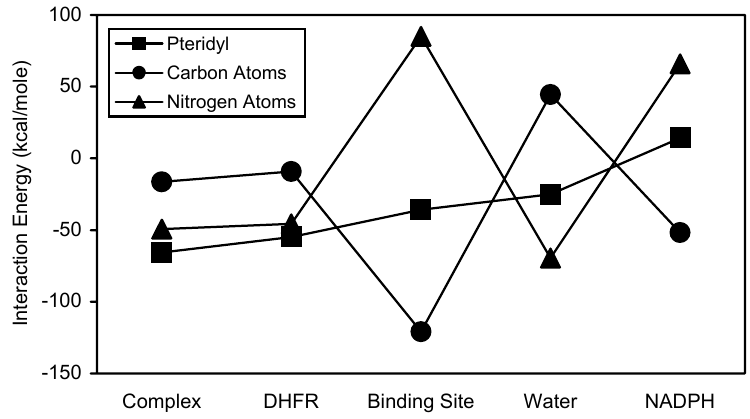
Figure 3. Comparison of interaction energy analyses of the pteridyl region of PTX with its carbon and nitrogen atoms.